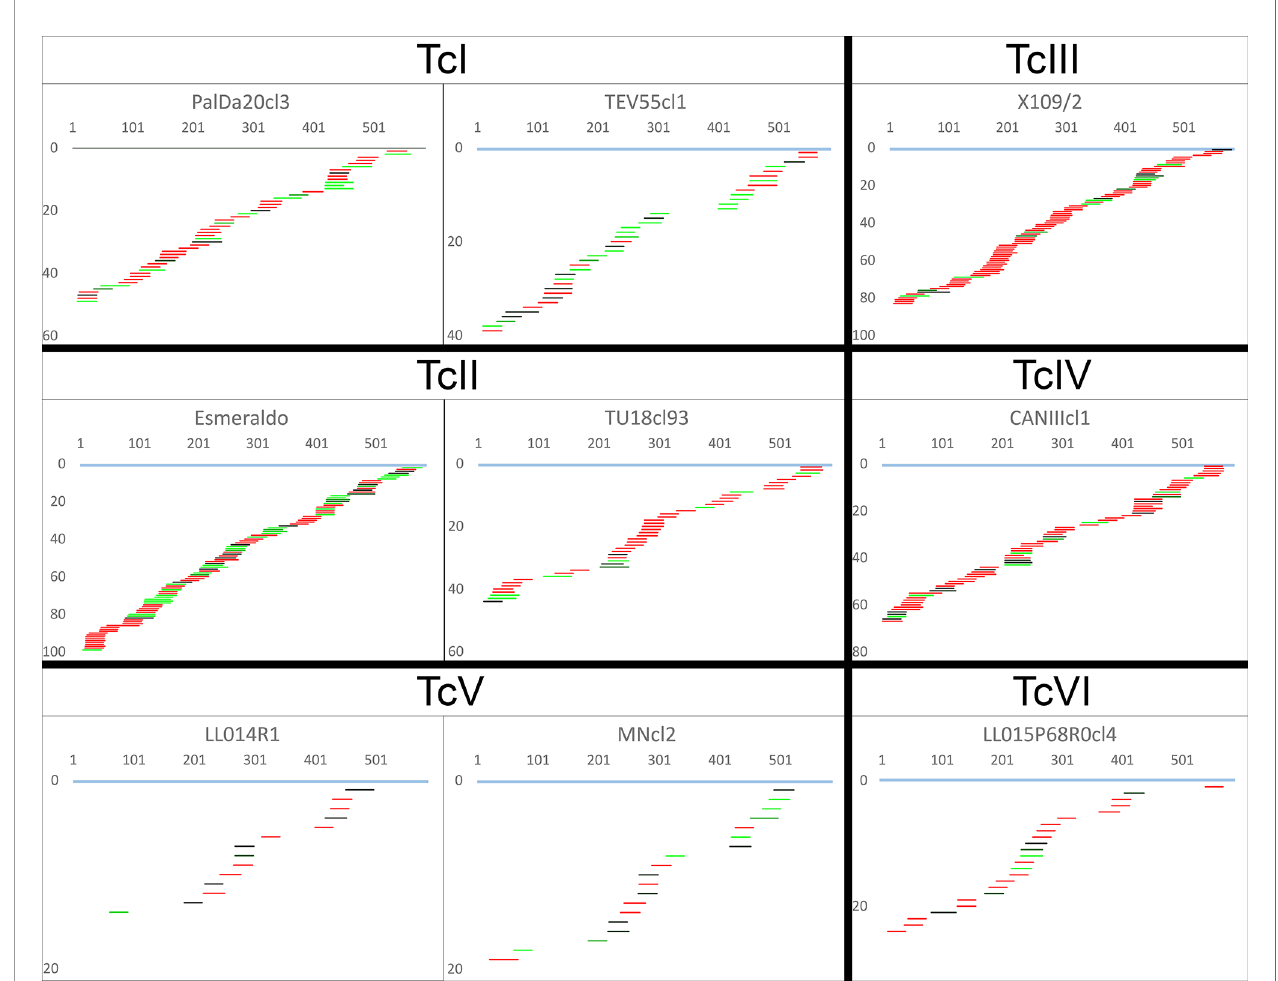
FIGURE 6 | Incomplete editing cascades for NADH dehydrogenase subunit 9. gRNA classes are shown aligned below the fully edited mRNA (light blue). The x-axis indicates mRNA position, and the y-axis indicates the accumulated number of gRNA classes until such mRNA position. gRNA classes are colored based on sequence abundance as follow: red (1-19 reads), black to green (20-1,000 reads), light-green (>1,000